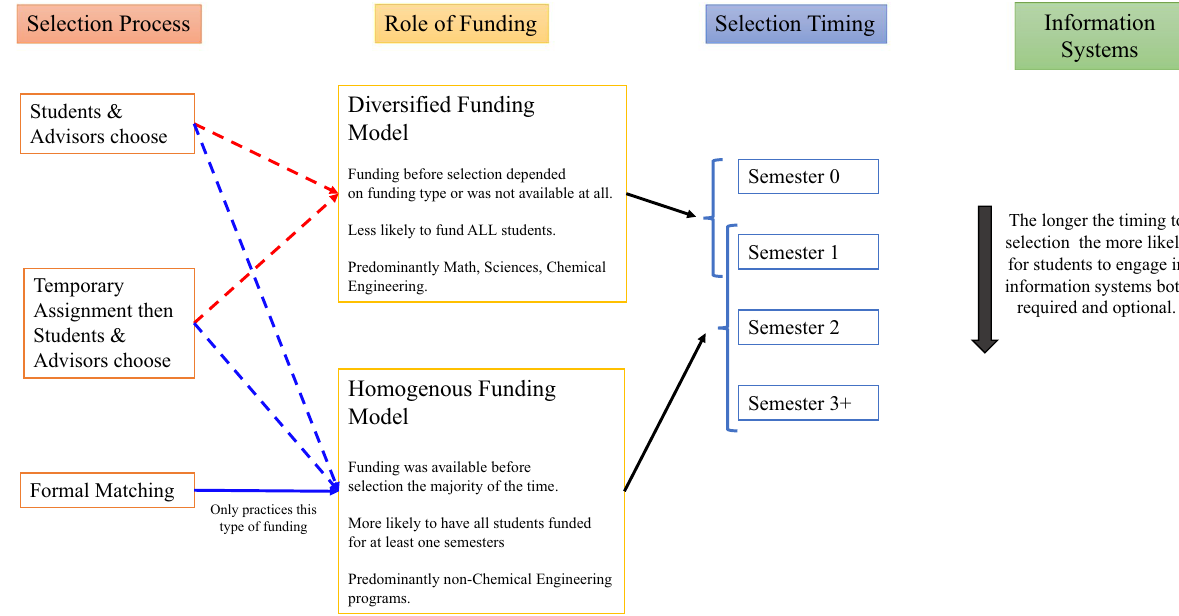
Fig. 4 Main components of any advisor selection